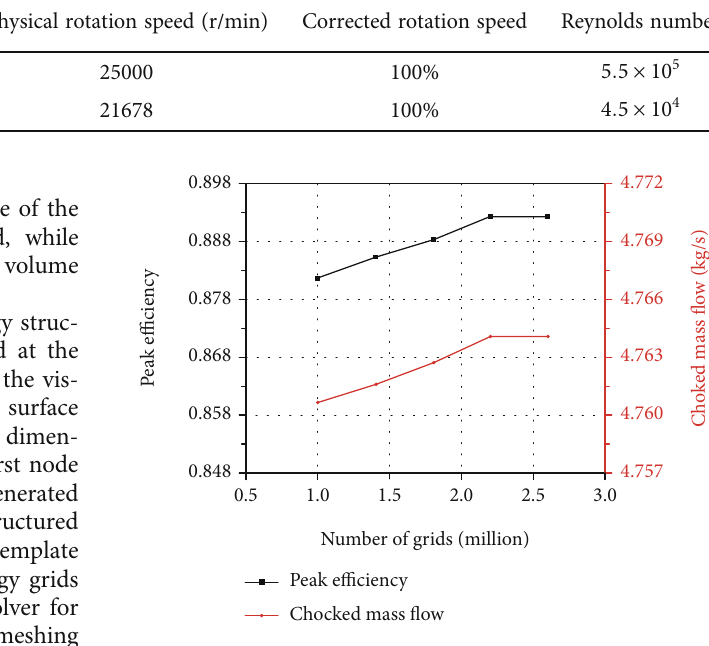
Figure 2: Grid independence